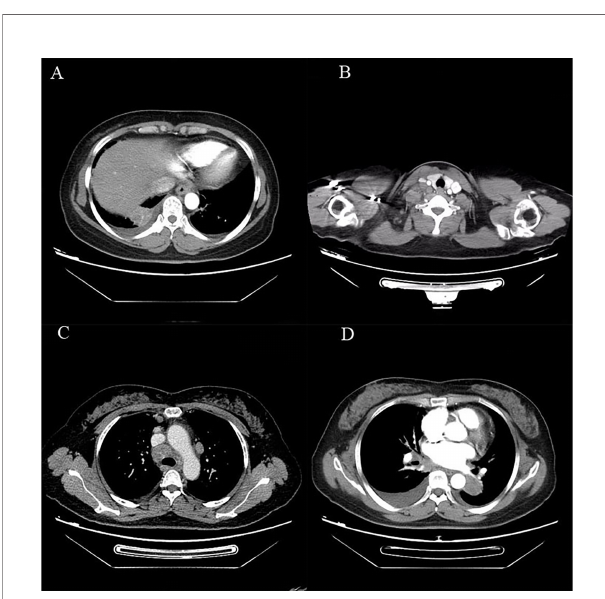
FIGURE 2 | Results of the fi rst puncture: (A) Microphotographs of small cell lung cancer; ( B – I ) thymic carcinoma with immunohistochemistry for CD56, CK, Syn, LCA, Ki67, P40, TTF-1,